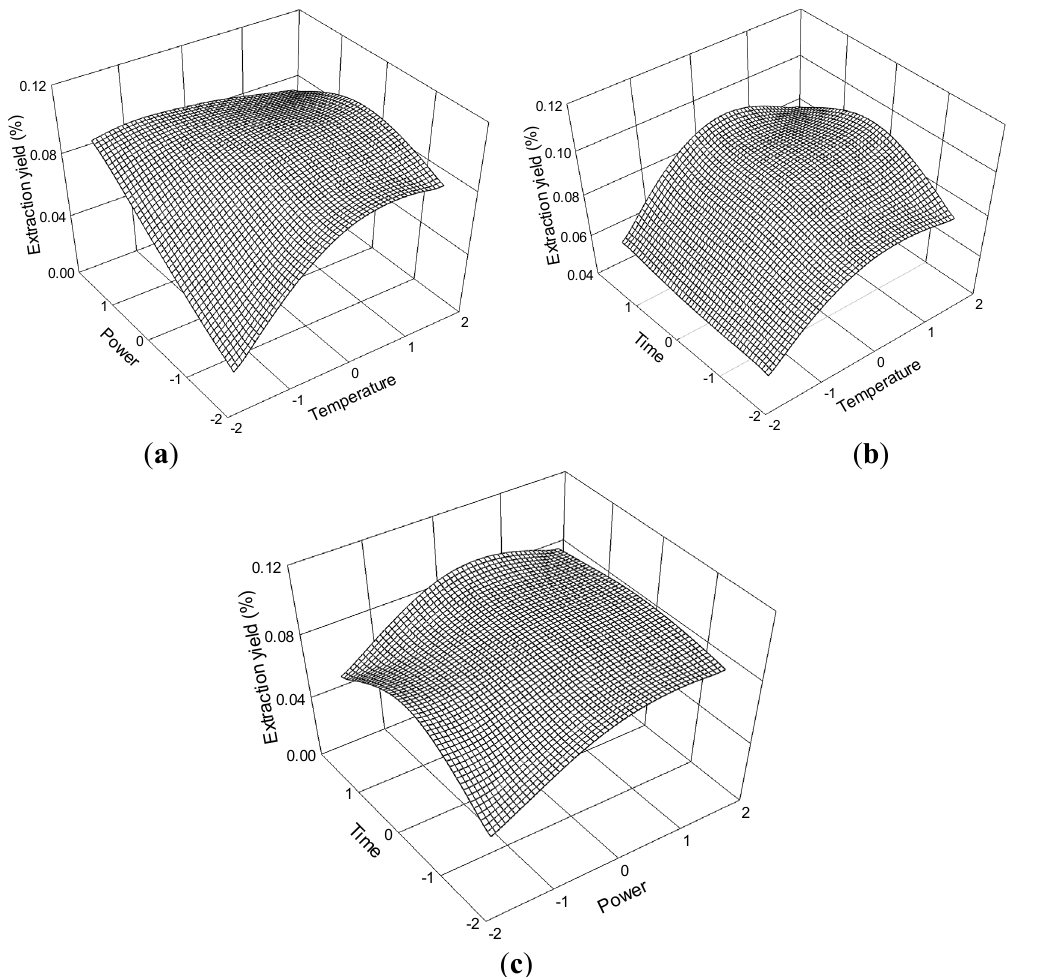
Figure 9. Response surface plots for the effects of ( a ) temperature/power ( b ) temperature/time ( c ) power/time on the extraction yield of senkyunolide